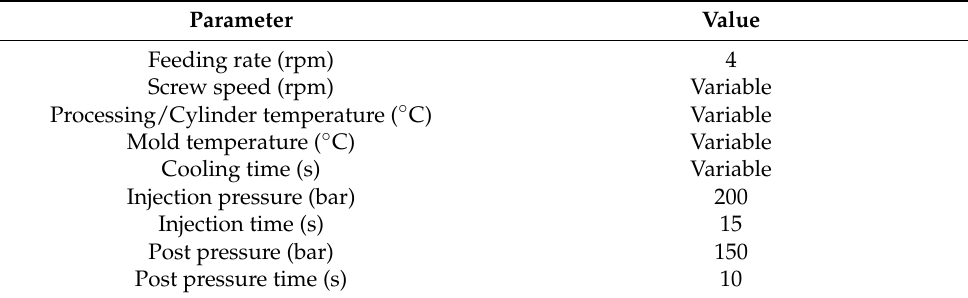
Table 1. Extrusion and injection molding parameter settings in the FFD approach.